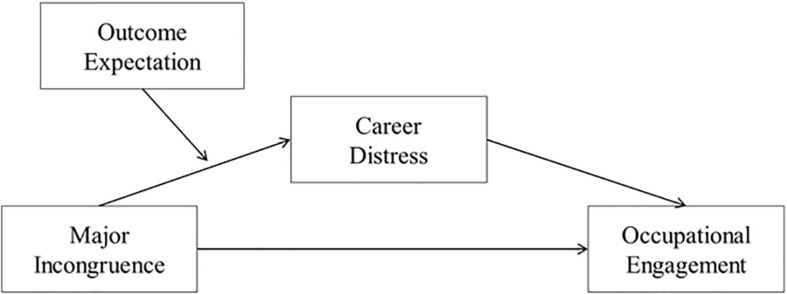
Theoretical model.